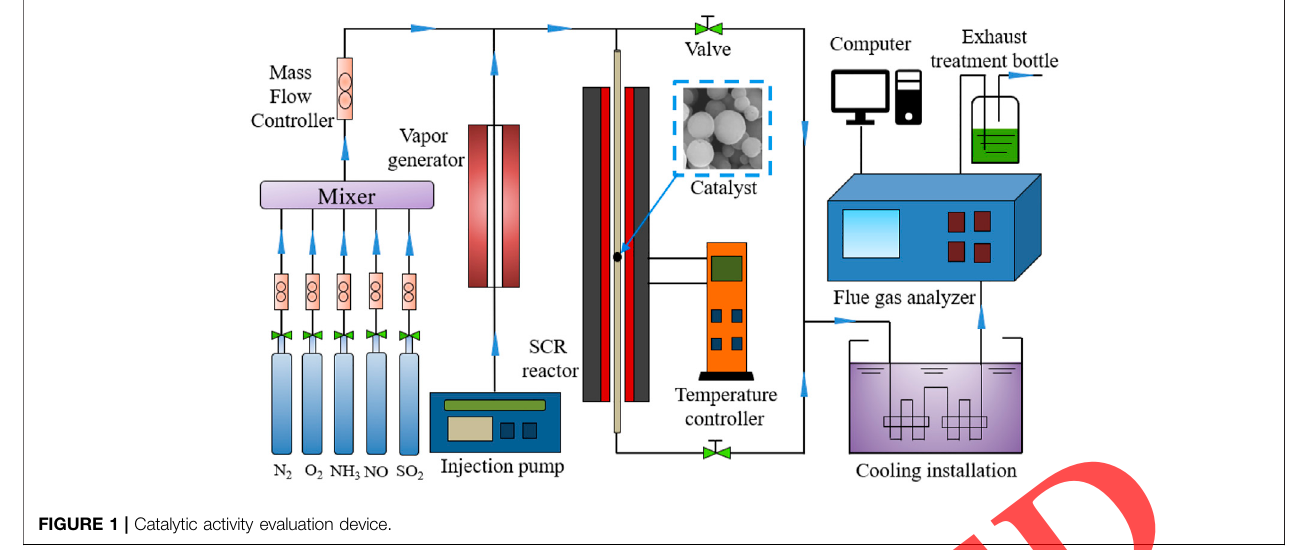
FIGURE 1 | Catalytic activity evaluation